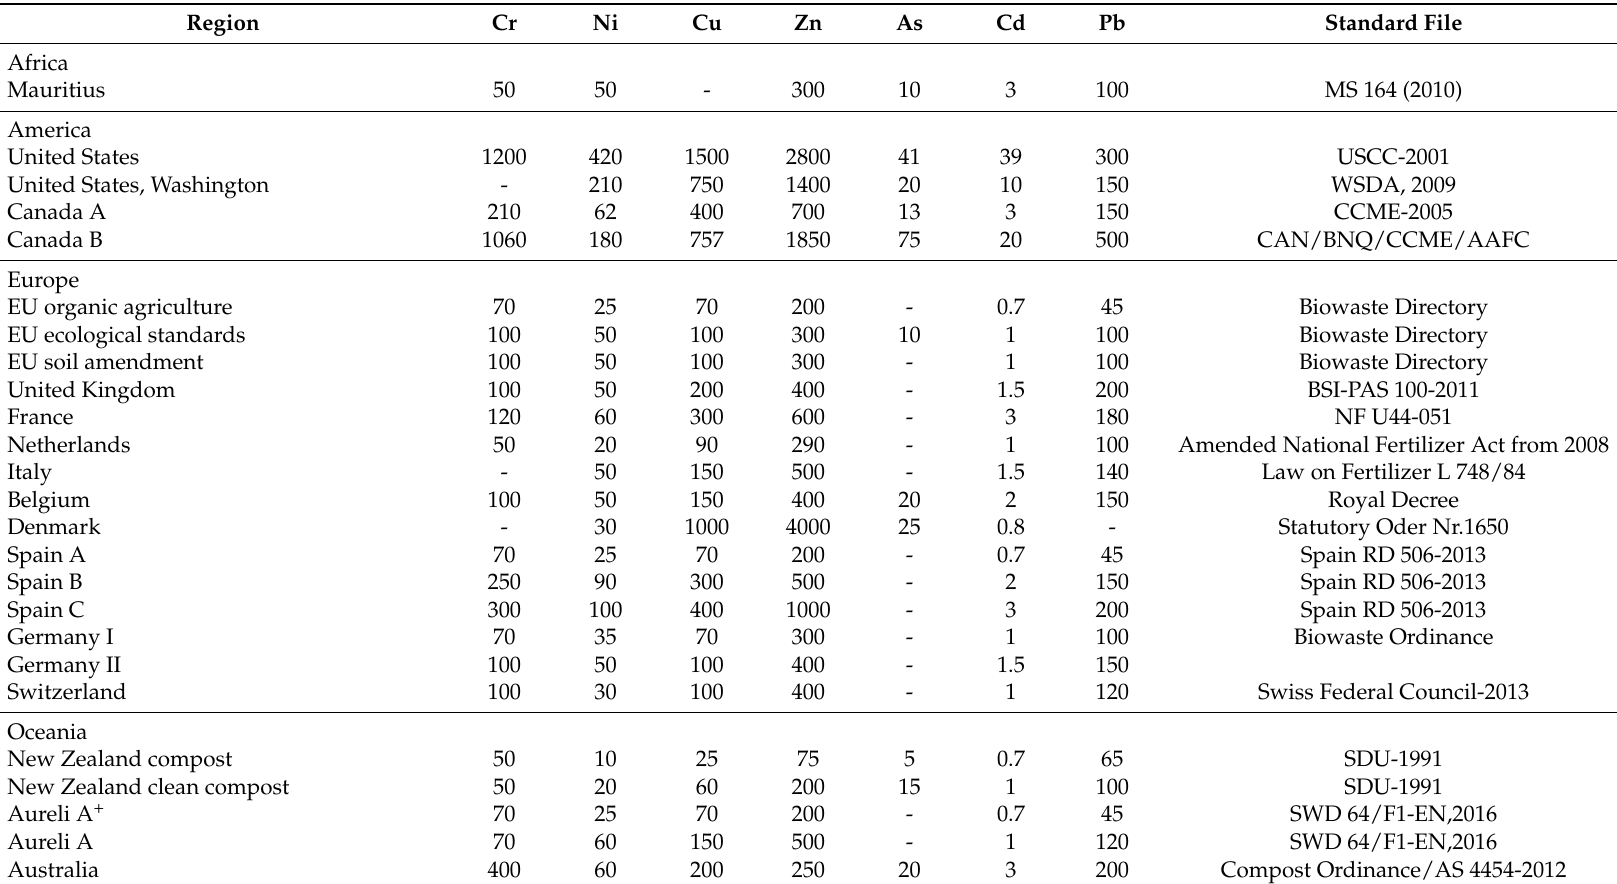
Table 6. Maximum trace metal concentration acceptable for compost in different countries (mg · kg − 1 ).